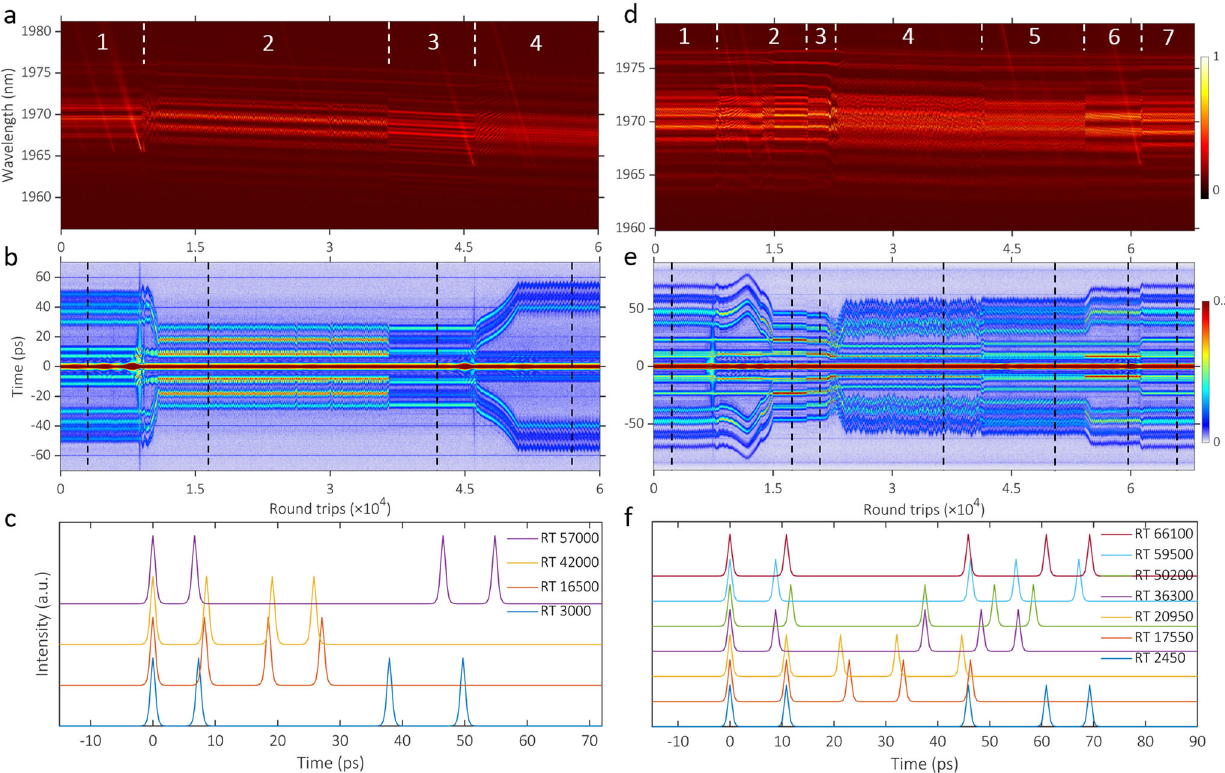
Fig. 4 Multiple switching of oscillating soliton molecular complexes. a – c Multipleswitchingof(2 + 2) oscillatingsolitonmolecularcomplexes. a Thereal-time spectral evolution measured via DFT. b The corresponding fi eld autocorrelation traces. c The temporal pulse distribution of several typical RTs corresponding to the black dashed lines in ( b ). d – f Multiple switching of (2 + 3) oscillating soliton molecular complexes. d The real-time spectral evolution measured via DFT. e The corresponding fi eld autocorrelation traces. f The temporal pulse distribution of several typical RTs corresponding to the black dashed lines in ( e